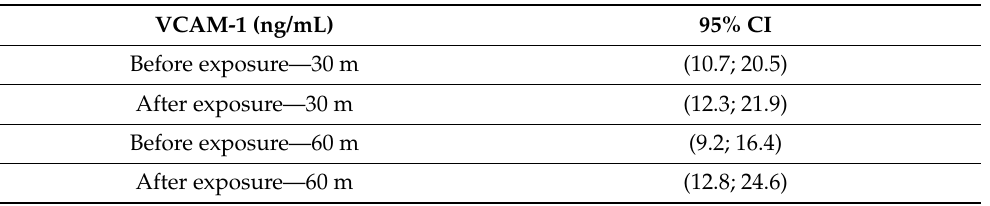
Table 4. 95% confidence intervals for the average level of VCAM-1 parameter measured in four tested situations in the divers group.